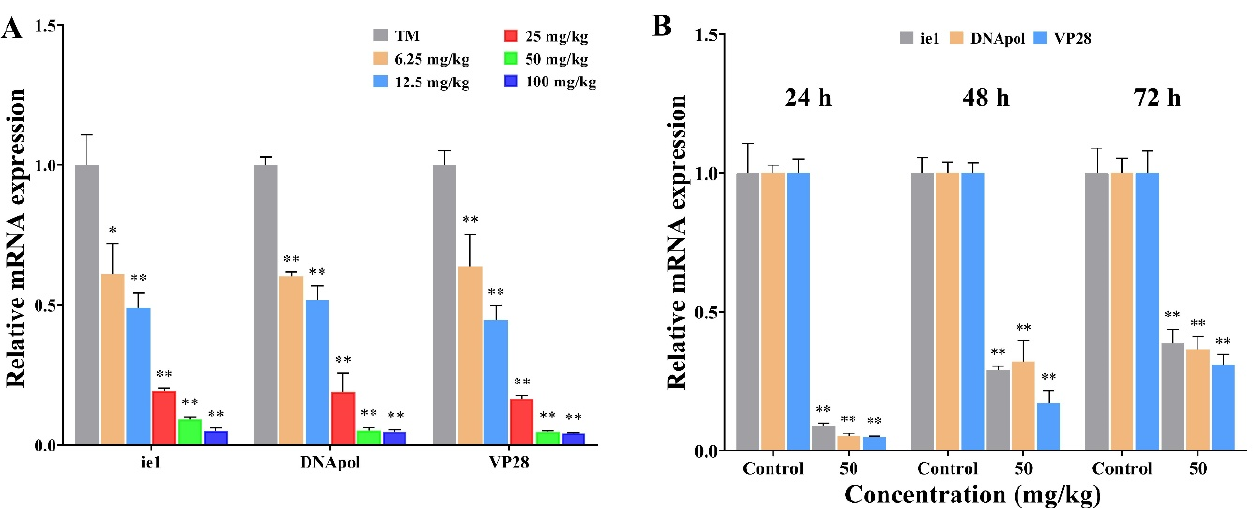
Figure 2. The effects of beta-sitosterol on the transcript levels of three vital viral genes ( ie1 , DNA pol , and VP28 ). The experimental workflow is described in Figure S3. ( A ) Influences of different beta-sitosterol contents (6.25, 12.5, 25, 50, and 100 mg/kg) on the transcript levels of WSSV genes at 24 hpi. ( B ) The transcript levels of WSSV genes were significantly inhibited by beta-sitosterol at 24, 48, and 72 hpi. The 18S gene served as an internal reference. The data are shown as mean ± SD (n = 5). Asterisks indicate the significant difference between the experimental and control groups (* p < 0.05, ** p < 0.01).